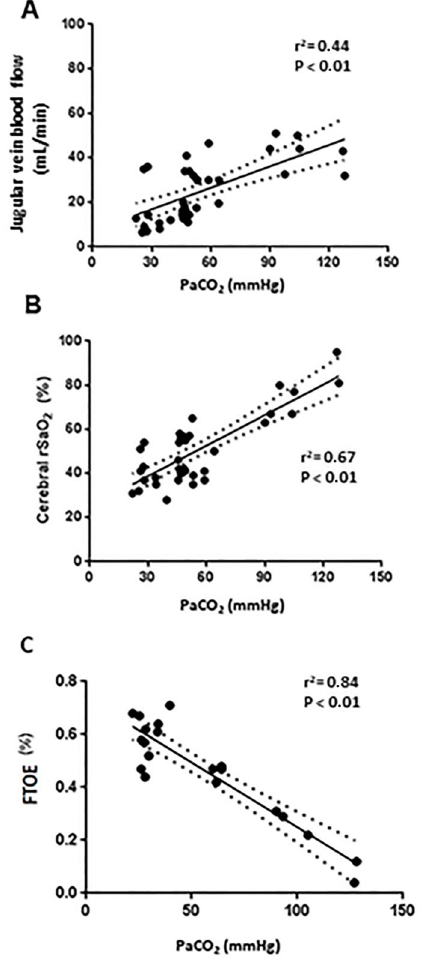
Figure 4. A , Linear regression between jugular venous blood fl ow and partial pressure of carbon dioxide (PaCO 2 ) during hyperven- tilation and hypoventilation maneuvers. B , Linear regression between cerebral oxygen saturation (rSaO 2 ) and PaCO 2 during hyperventilation and hypoventilation maneuvers. C , Linear regression between cerebral fractional tissue oxygen extraction (FTOE) and PaCO 2 during hyperventilation and hypoventilation maneuvers.